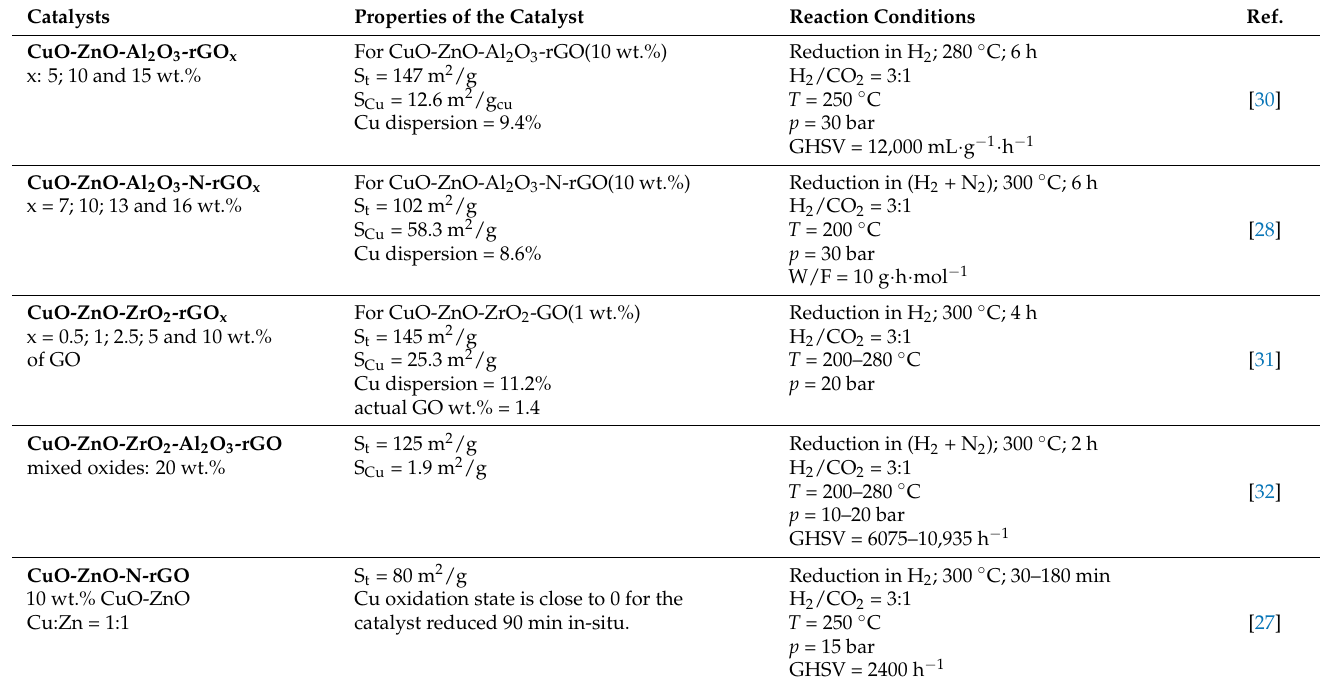
Table 2. Graphene-based catalysts for CO 2 hydrogenation to